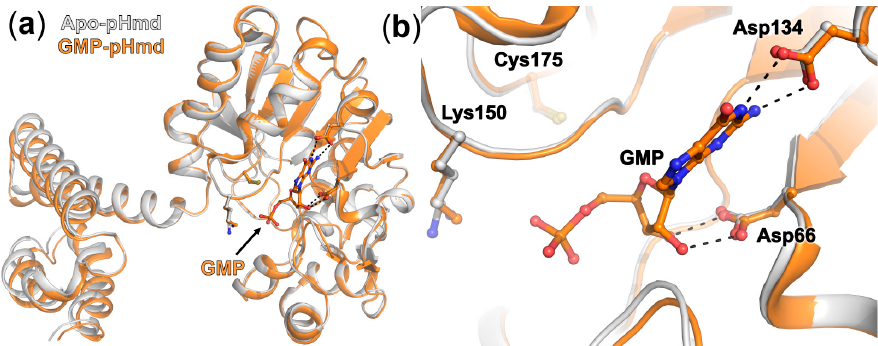
Figure 3. Structural comparison of the apo-form of the pHmd asymmetric-homodimer (grey) and the GMP-bound form (orange) of pHmd. ( a ) Monomers of each structure is shown by cartoon model. The N-terminal domains were superposed. ( b ) Zoom-up view of the GMP binding site. GMP is shown as ball and stick model. Hydrogen bonds are indicated by dashed lines.